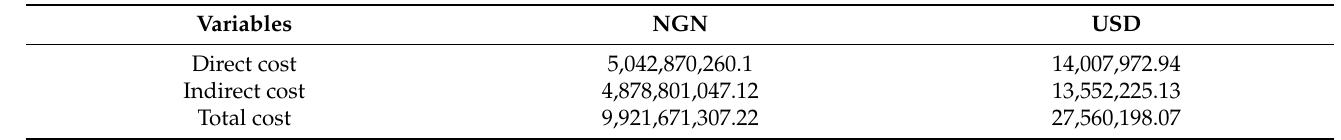
Table 7. Projected annual economic burden due to uncomplicated malaria on patients in